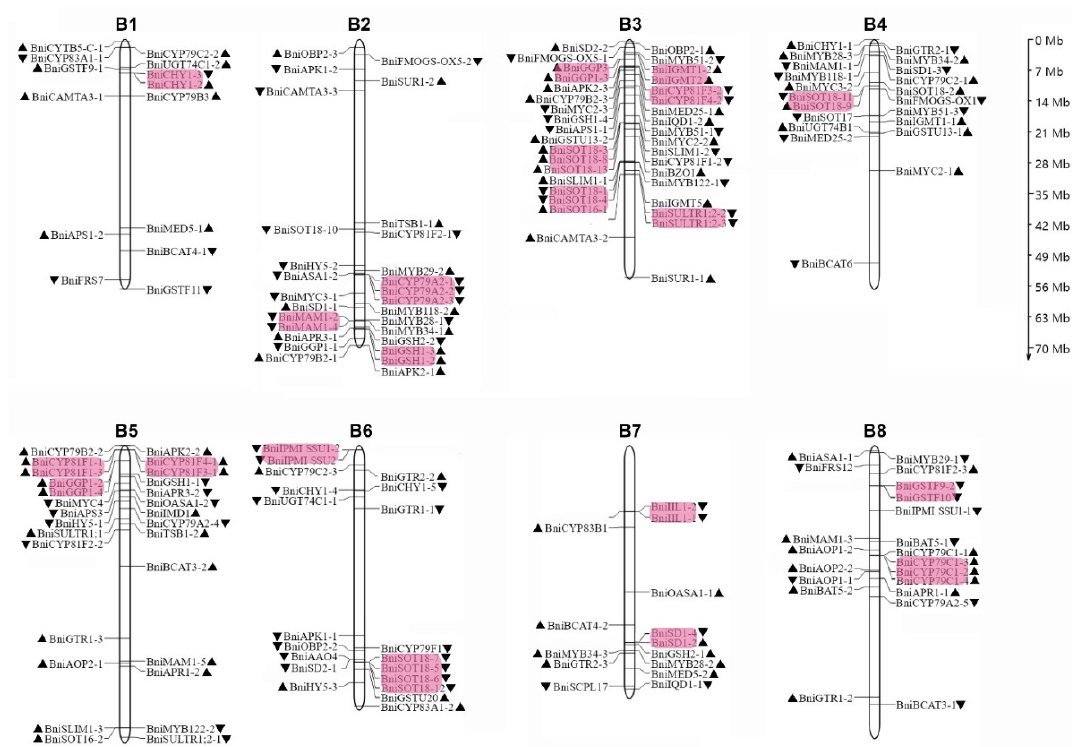
Figure 1. Genomic distribution of glucosinolate genes ( BniGSLs ) on the chromosomes of Brassica nigra . The arrowheads next to gene names show the direction of transcription. The chromosome numbers are demonstrated at the top of each chromosome. Tandem repeat genes are marked with a pink background.